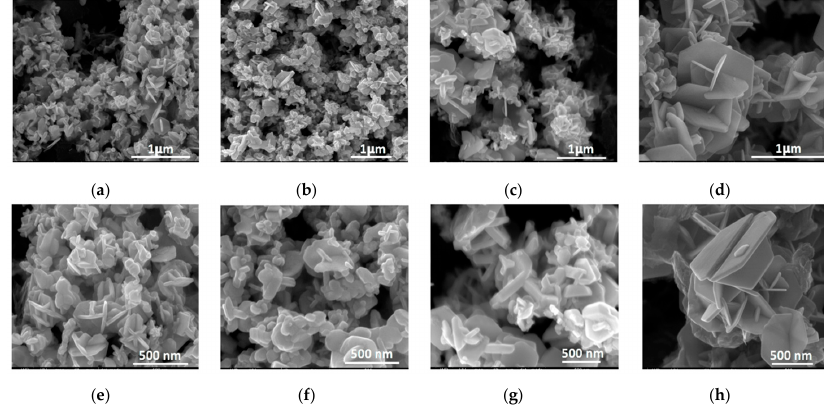
Figure 2. SEM micrographs at different magnifications of as-synthesized: ( a , e ) Bi 2 Te 3 ; ( b , f ) Bi 1.8 Sb 0.2 Te 3 ; ( c , g ) Bi 0.5 Sb 1.5 Te 3 ; and ( d , h ) Sb 2 Te 3 .